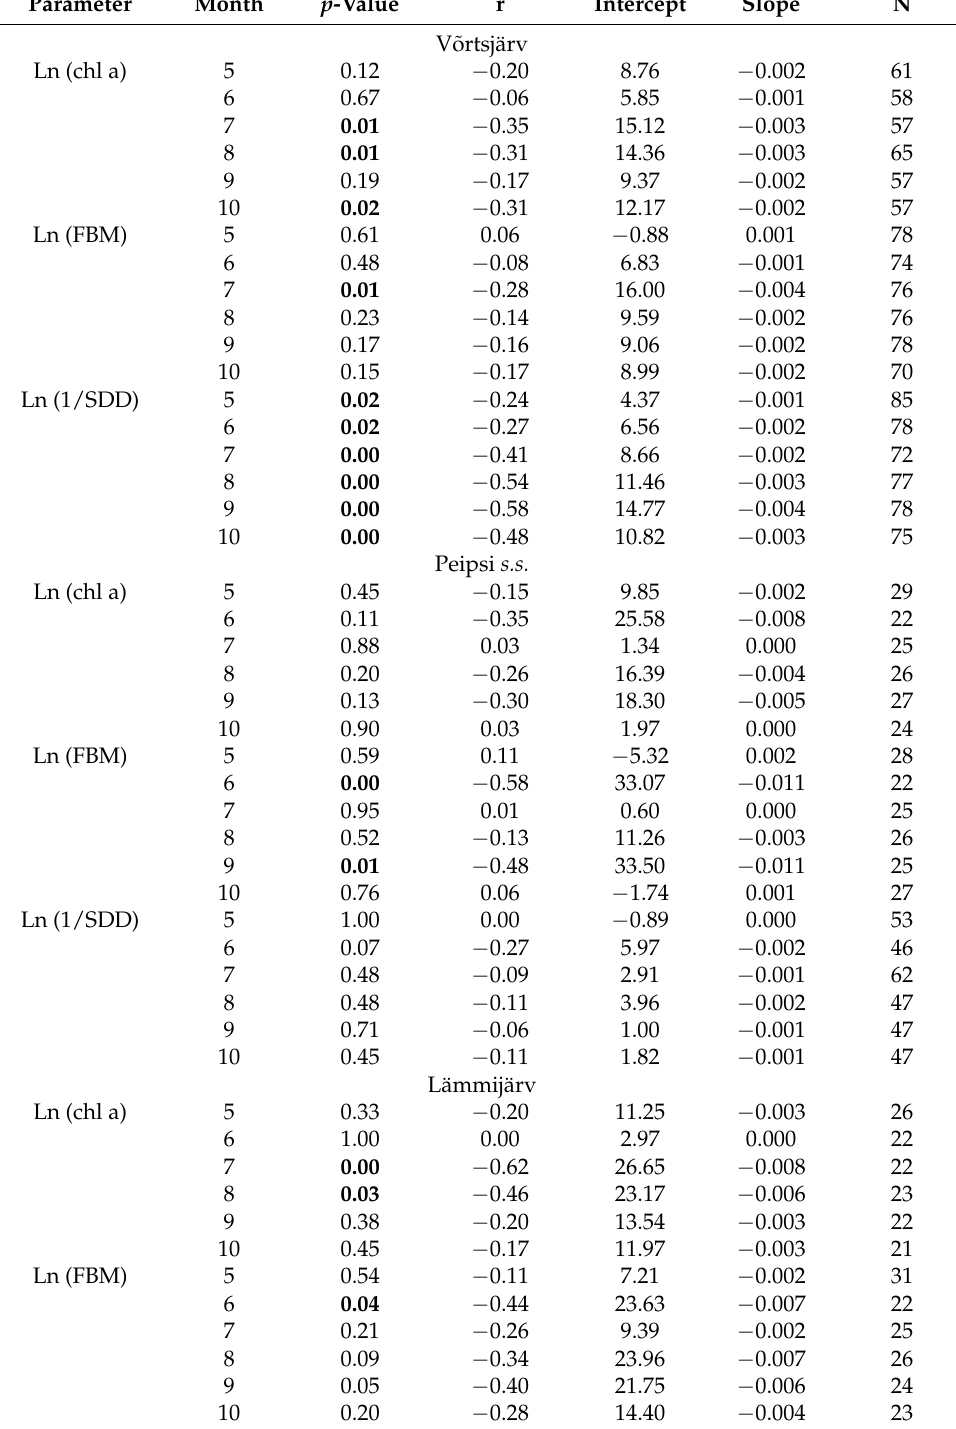
Table A1. Relationship between in situ measured WL (cm) and water quality parameters from May (5) to October (10), where bold values indicate statistically significant relationships ( p < 0.05), N indicates number of observations during the study period and “-” indicates not enough observations for statistical